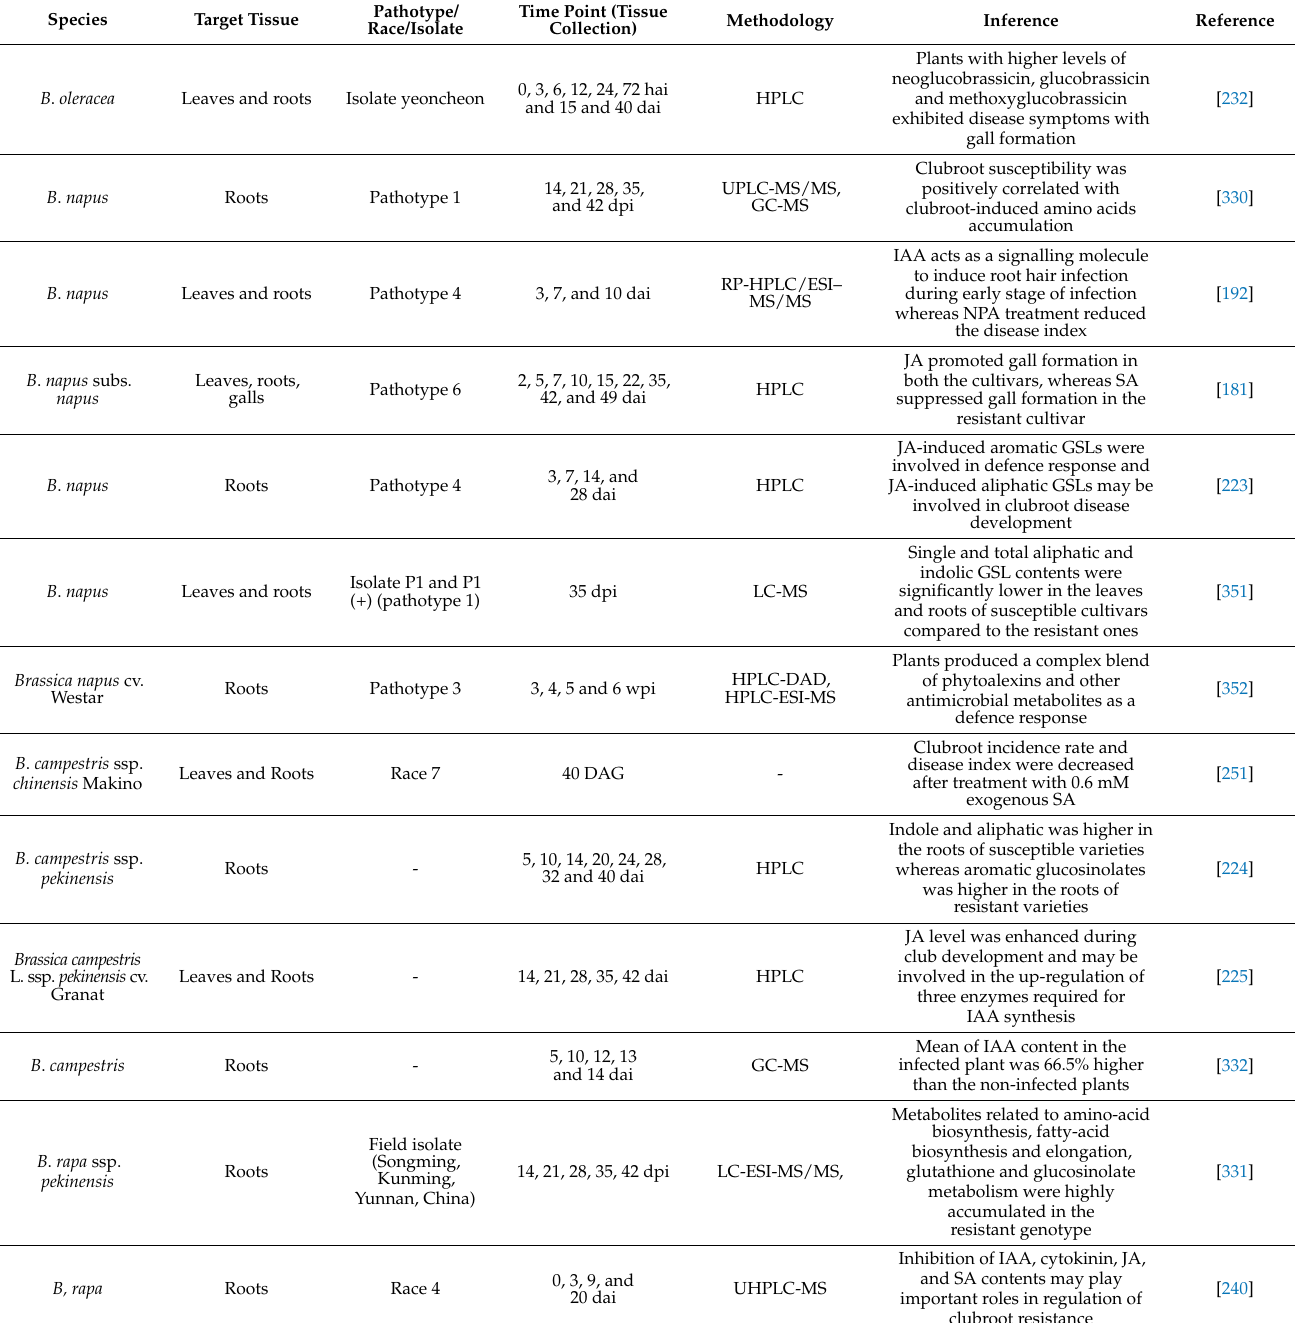
Table 6. Published metabolomic analyses in Brassica spp. involved in resistance against